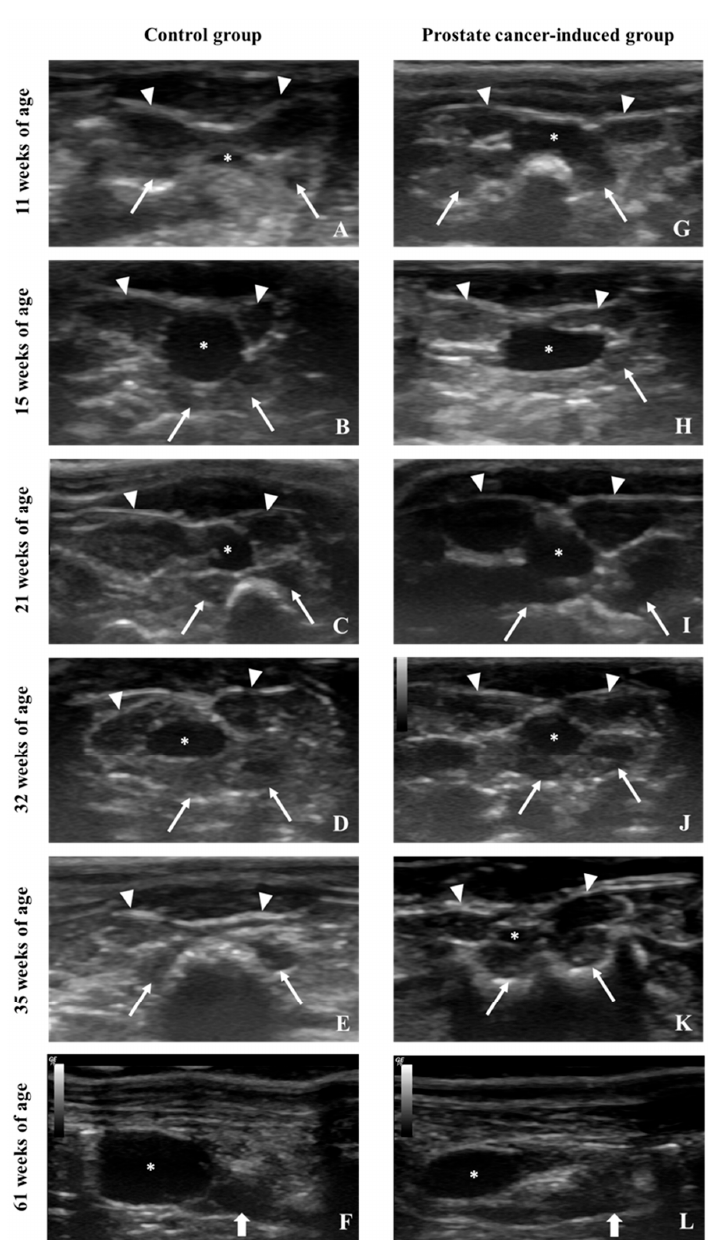
Figure 6. Prostates of both control ( A – F ) and prostate cancer-induced ( G – L ) animals were monitored by ultrasonography through the experimental protocol at the same time points. Transverse scans